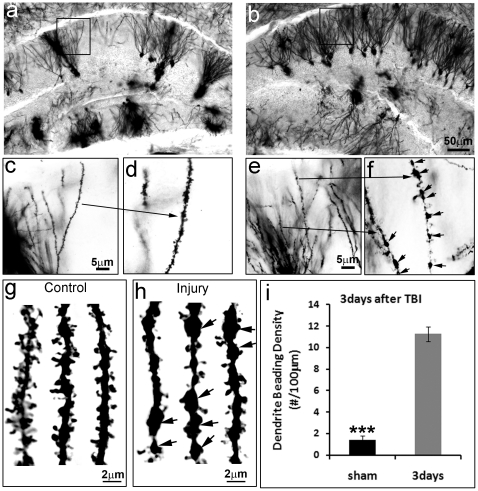
Moderate TBI causes dendrite degeneration in the HDG.Golgi staining revealed the individual neurons including their processes and spines both in the control (a, c, d and g) and the moderate CCI injured hippocampus (b, e, f and h). The dendrites and spines of the spared neurons in the injured HDG were significantly damaged. Quantitative data showed that the number of dendrite beadings, the hallmark of an injured dendrite was increased dramatically in the HDG of TBI mice HDG as compared with sham control (i). (n = 5, ***, p<0.005).